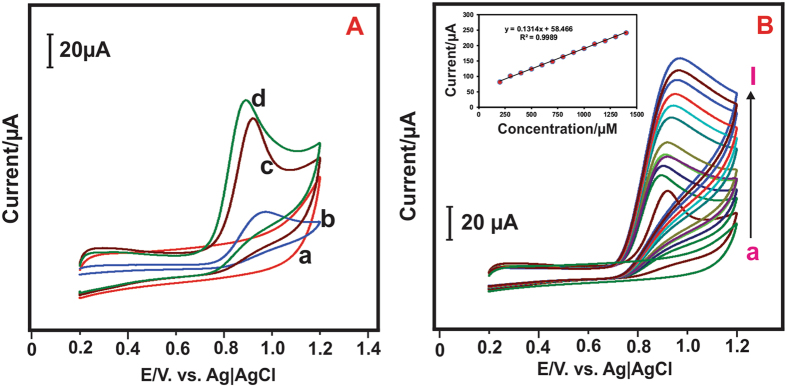
(A) Cyclic voltammetry of (a) GCE/CeO2 NPs-b nanocomposite modified electrode in absence of nitrite and (b) bare GCE, (c) GCE/CeO2NPs-a (d) GCE/CeO2NPs-b in 0.05 M PBS (pH 5) containing 200 μM nitrite at scan rate 50 mV s−1. (B) cyclic voltammetry response of CeO2NPs modified electrode at different concentration of nitrite in 0.05 M PBS (pH 5) at the scan rate 50 mV s−1.